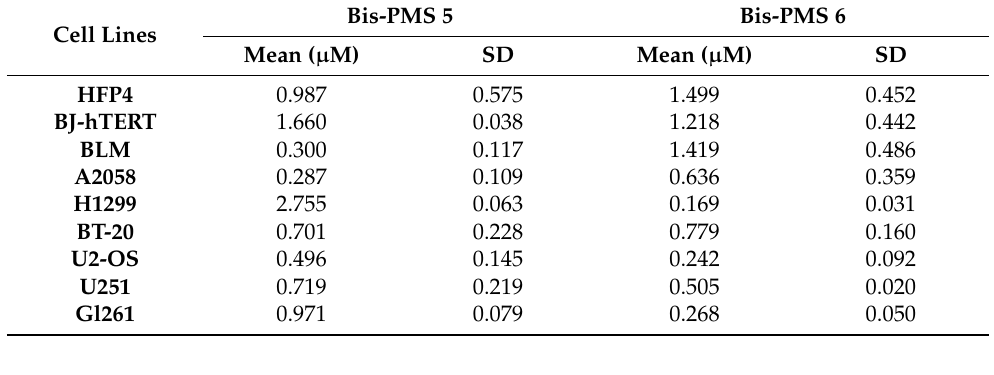
Table 1. Cytotoxicity of Bis-PMSs 5 and 6 in normal and cancer cells. IC 50 ( µ mol/L) of Bis-PMSs 5 and 6 was determined in HF-P4 and BJ-hTERT human fibroblasts, BLM and A2058 human melanoma cells, H1299 human non-small cell lung cancer cells, human BT-20 breast cancer cells, human U251MG and mouse Gl261 glioblastoma cells and U2-OS human osteosarcoma cells. Cell Lines